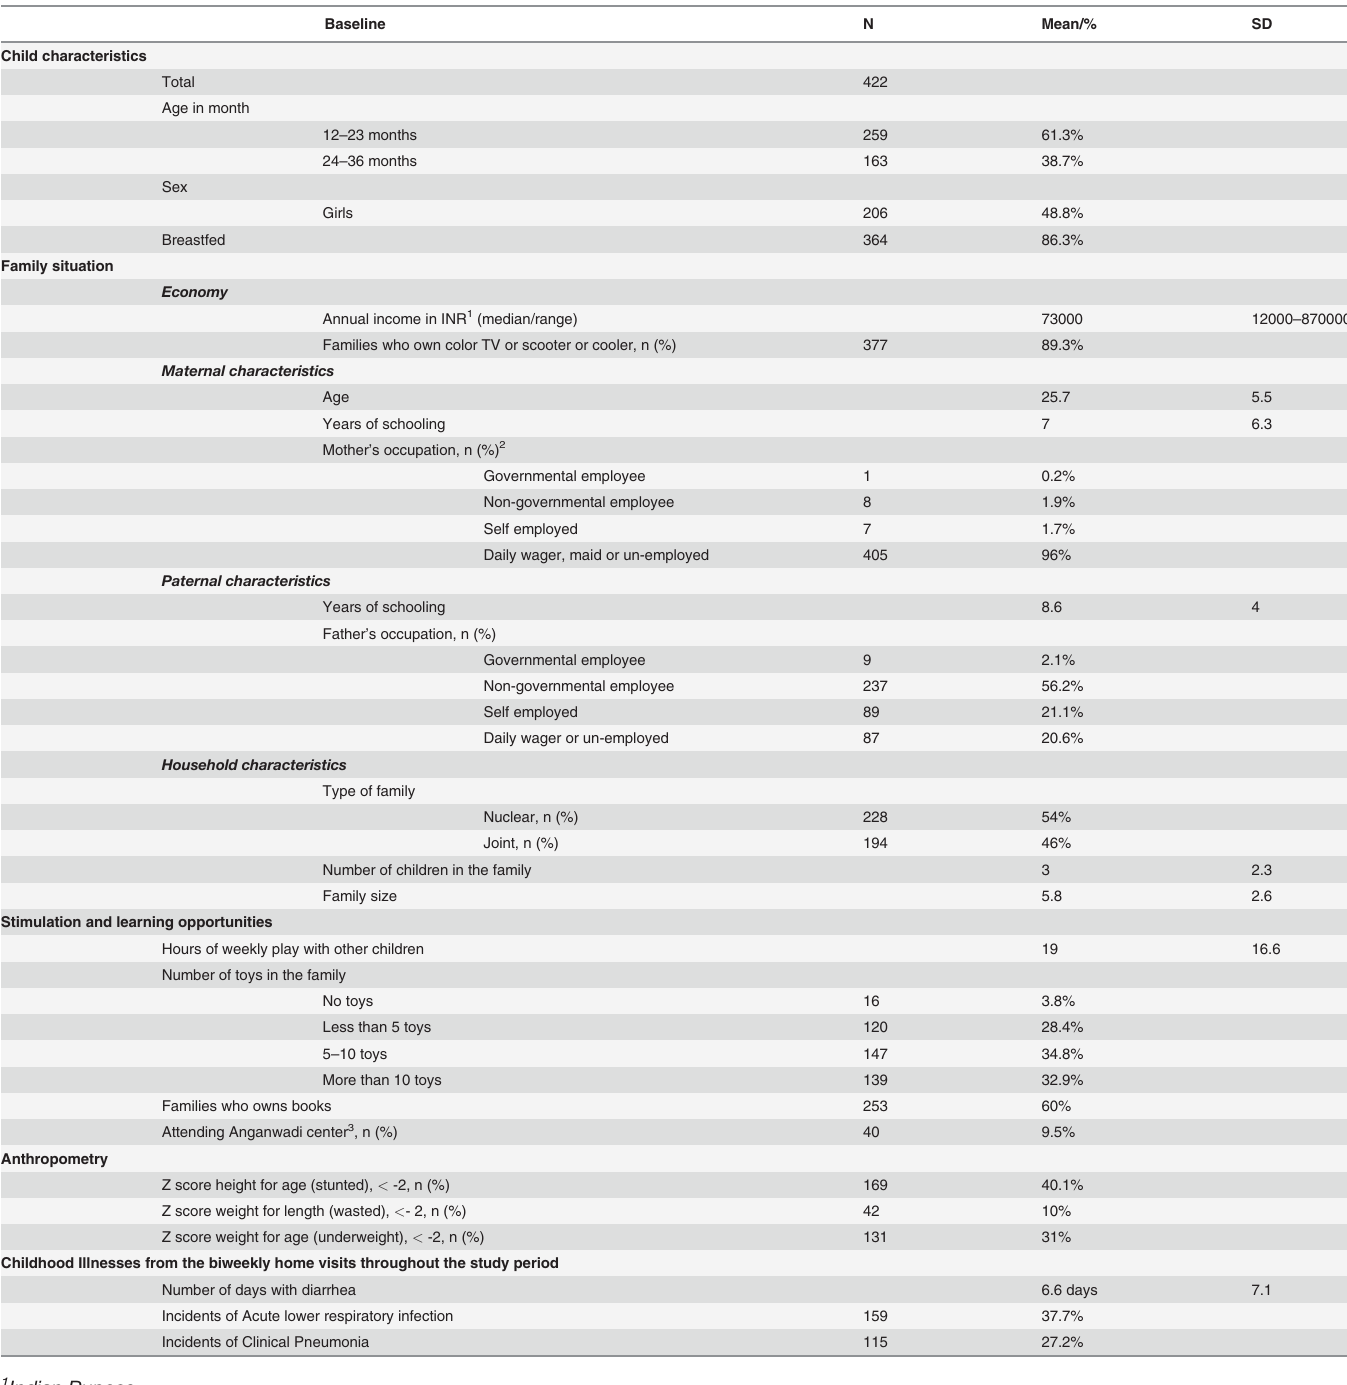
Table 1. Demographic and clinical characteristics of children in the